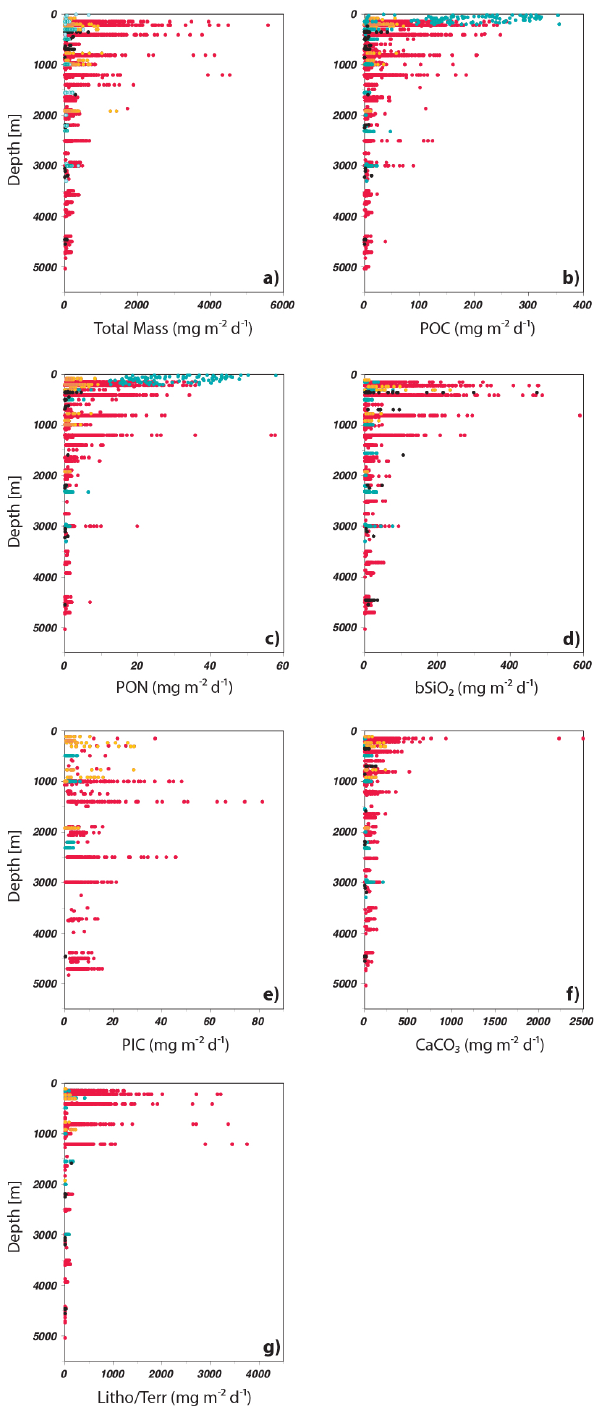
Figure 5. Downward fluxes plotted against depth; (a) total mass, (b) POC, (c) PON, (d) bSiO 2 , (e) PIC, (f) CaCO 3 , and (g) Litho / Terr. Data points are colour-coded per ocean domain: At- lantic (red dots), Mediterranean (orange dots), Arctic (blue dots), and Southern Ocean (black